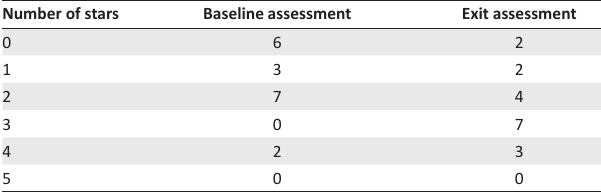
TABLE 3: ‘Stars’ at baseline and exit for 18 tuberculosis laboratories in four countries completing the TB SLMTA programme (2013–2016). † Number of stars Baseline